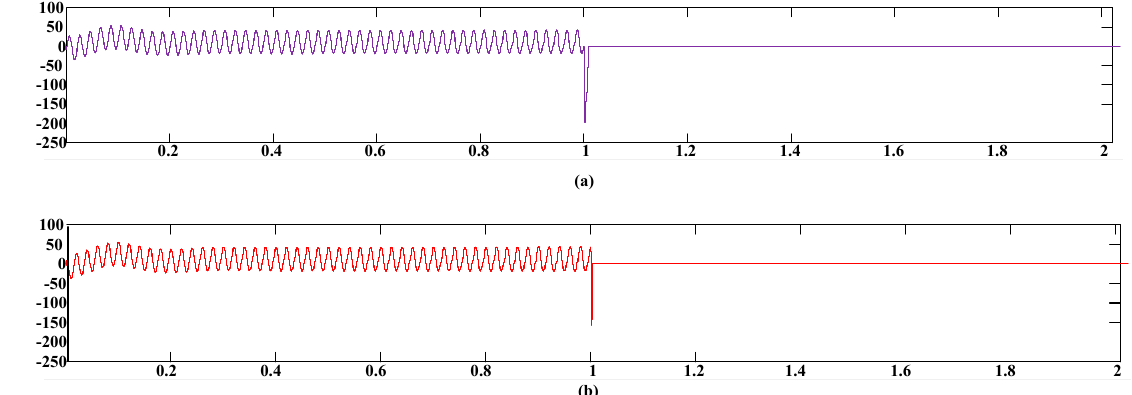
Figure 15. Arm Current with fault blocking: ( a ) i Ua and ( b ) i Uc .